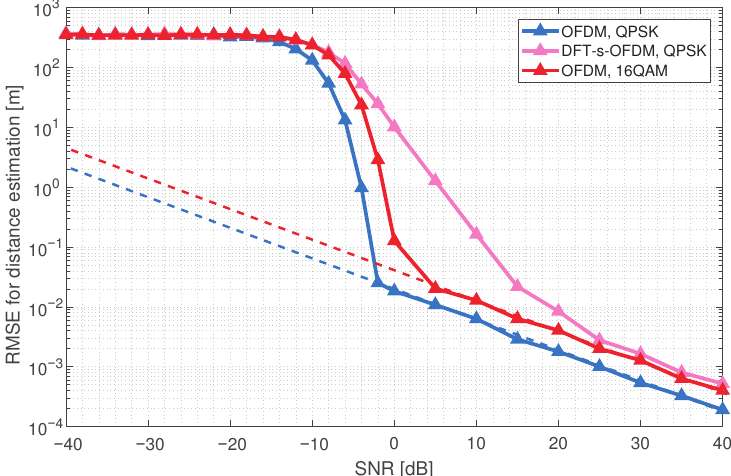
Figure 4. Comparison of the RMSE for distance estimation between 16 QAM and